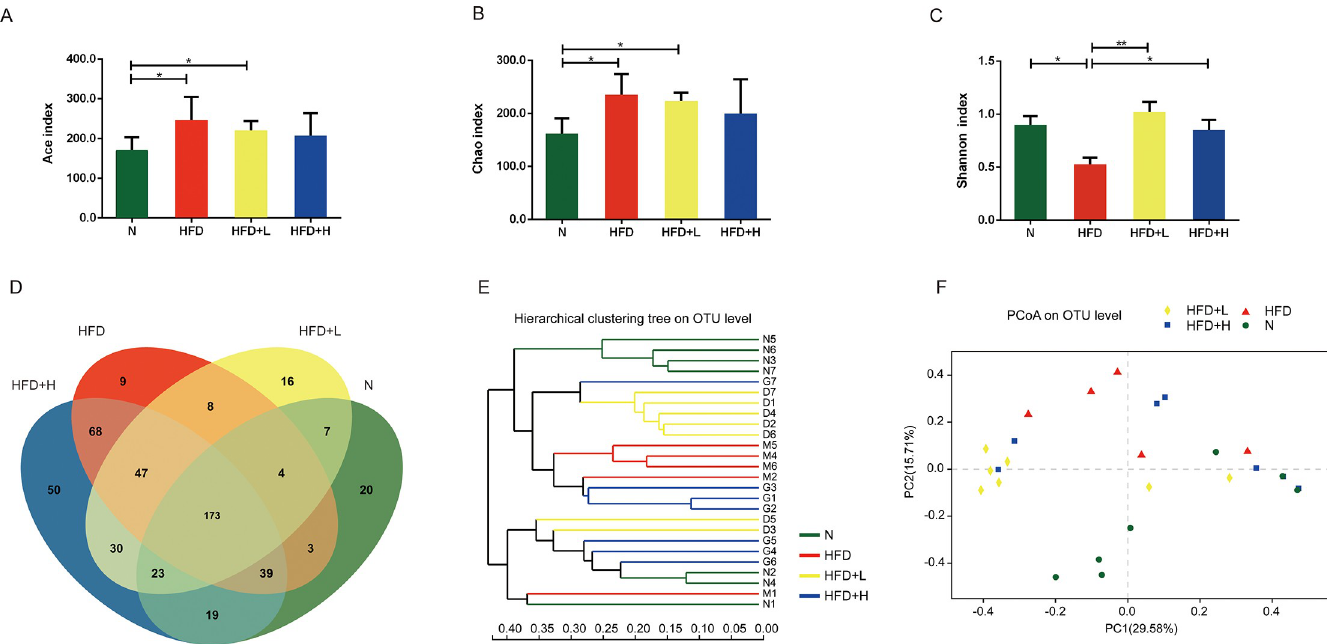
Fig 2. Microbiota changes in the composition of HFD-induced ApoE-/- mice by YNKB. The rarefaction curves of alpha diversity ((A) Ace, (B) Chao, or (C) Shannon index); (D) Venn diagram of the OTUs in the three groups; The beta diversity as measured by (E) hierarchical clustering tree and (F) unweighted Unifrac PCoA